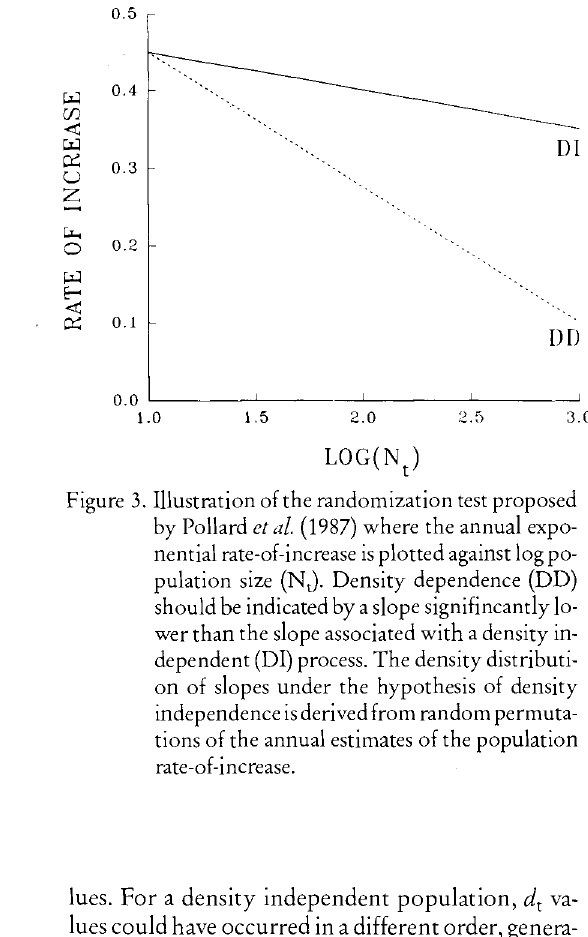
lues. For a density independent population, d t